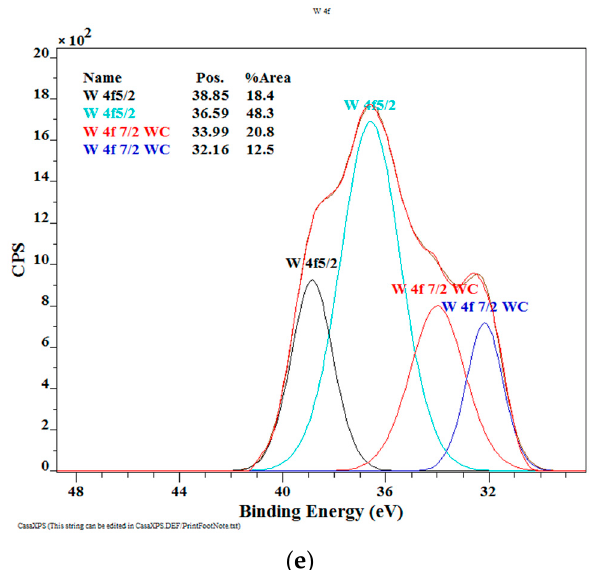
Figure 4. The XPS spectra of the deposited WC/C coatings: ( a ) Chemical composition (at.%); ( b – e ) chemical bonds of selected elements.